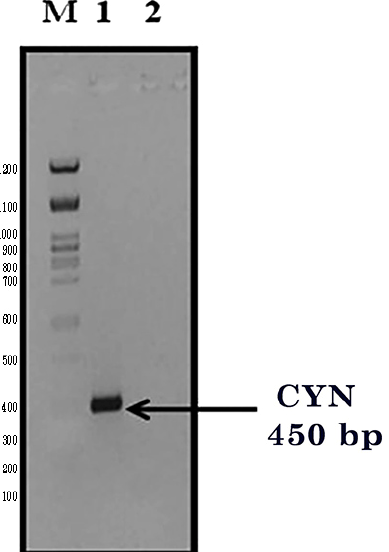
Figure 2. PCR product of the CYN amplification (450 bp). M: 100 bps DNA ladder, Lane 1: amplified CYN gene fragment, Lane 2: negative PCR control.